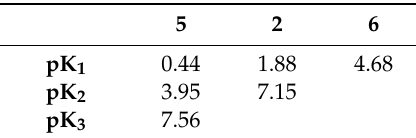
Table 9. Dissociation constants of compounds p -aminophenylphosphonic acid 5 , phenylphosphonic acid 2 , and anilinium hydrochloride